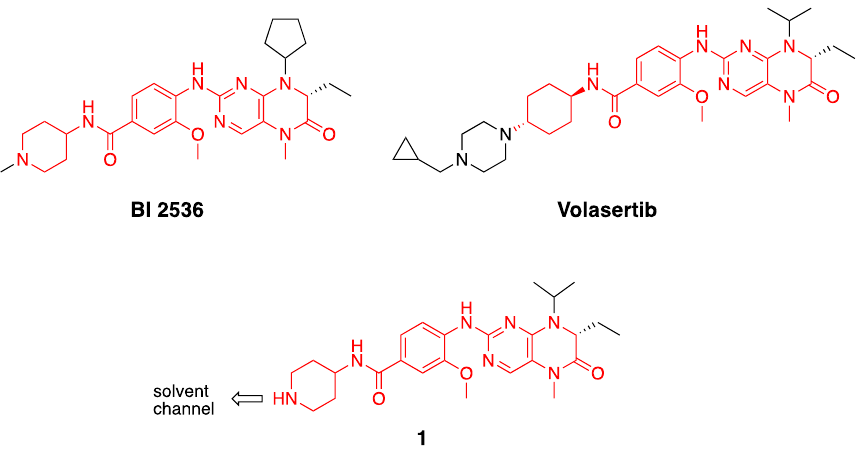
Figure 1. Structures of PLK inhibitors BI 2536 and volasertib, and design of intermediate 1 . The common anilino-tetrahydropteridine core is shown in red.